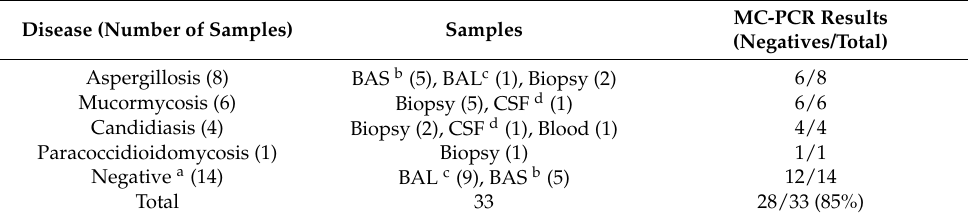
Table 5. MC-PCR (melting curves PCR) results for control samples. Disease (Number of